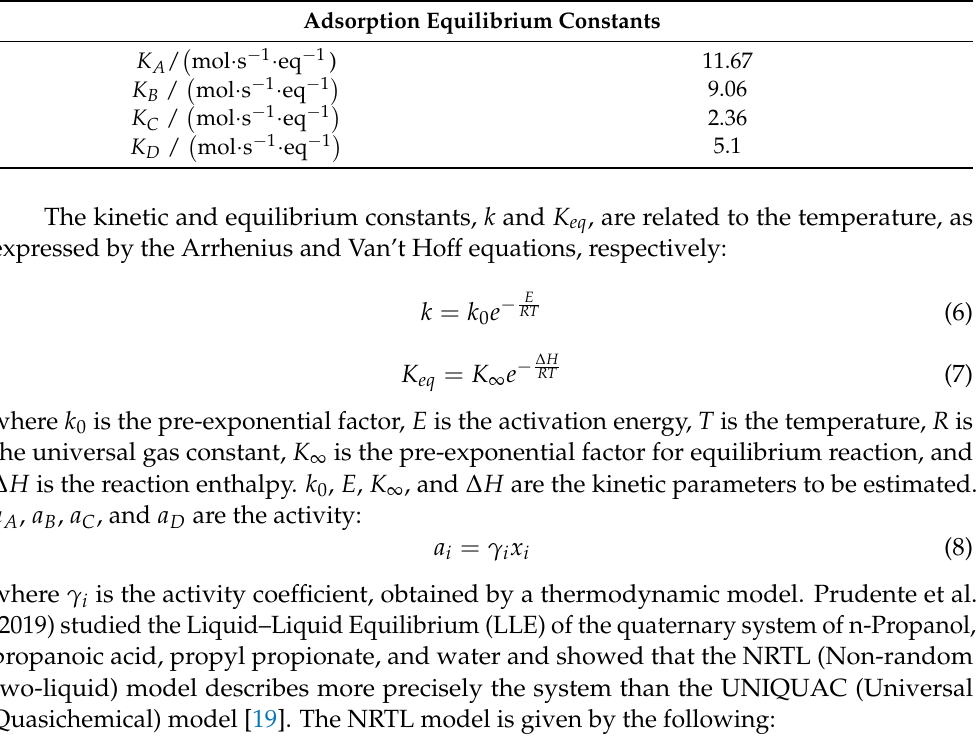
Table 2. Adsorption equilibrium constants for reactants and